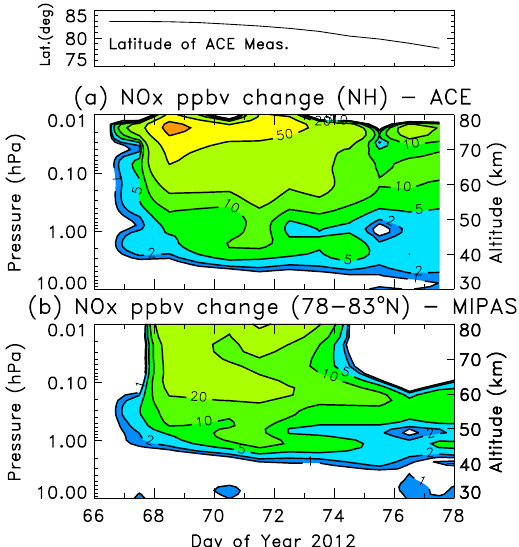
Fig. 9. Daily averaged NO x (NO + NO 2 ) changes from DoY 66 (6 March) 2012 values as measured by ACE (a) and MIPAS (78– 83 ◦ N) (b) . The contour intervals for the NO x differences are 1, 2, 5, 10, 20, 50, and 100ppbv. The northern polar latitudes of ACE measurements are given in the Top plot.